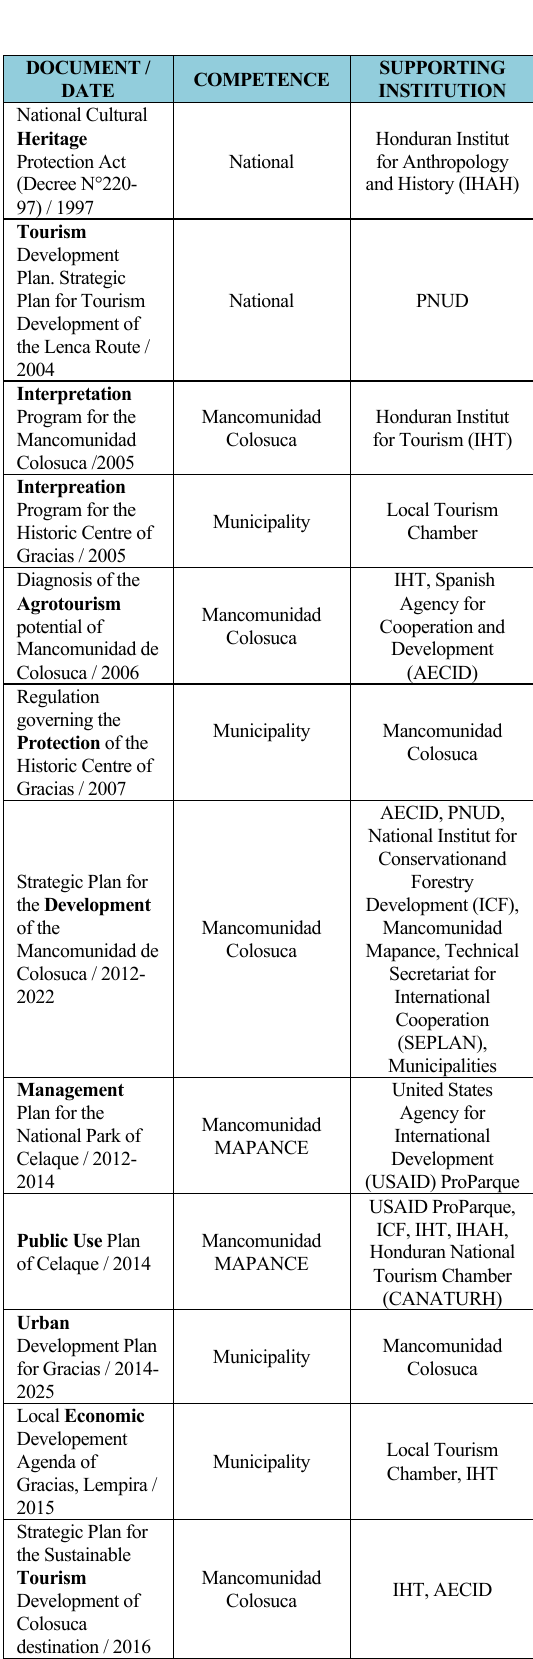
Table 2. Instruments for heritage and tourism